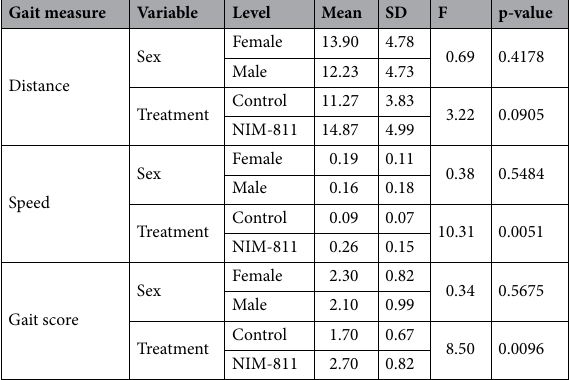
Table 2. Two-factor main effects ANOVA model results on gait measures.